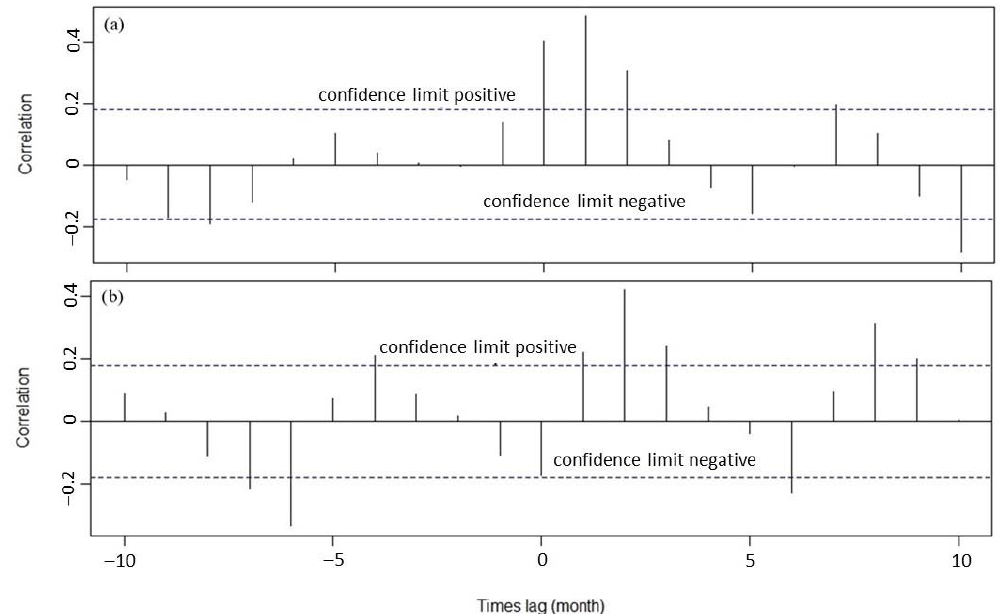
Figure 4. Time-lag cross-correlation coefficient between ( a ) SSC (mg/m 3 ) and DMI; ( b ) SSC (mg/m 3 ) and Sardinella lemuru catches at the fishing port around the Bali Strait. Blue dashed line is the confidence limits. The analysis focuses on the peak season of IOD (June to November).